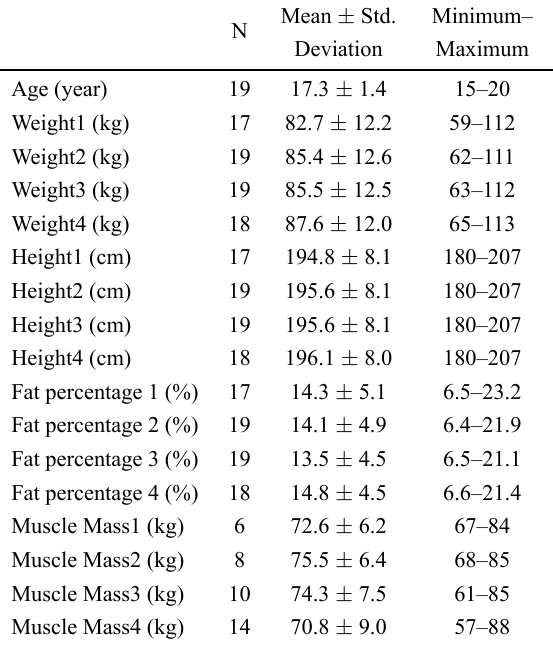
Table 3. The comparisons of the median differences’ values of each measured vertical jump